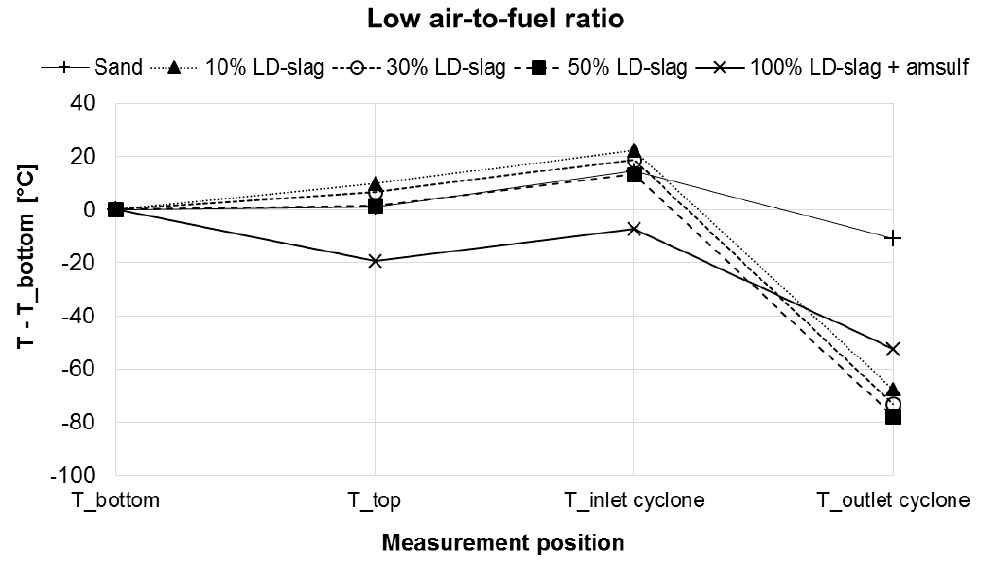
Appl. Sci. 2018 , 8 , x FOR PEER REVIEW Figure 4. Temperature profile over the boiler when operated with low air-to-fuel-ratio.